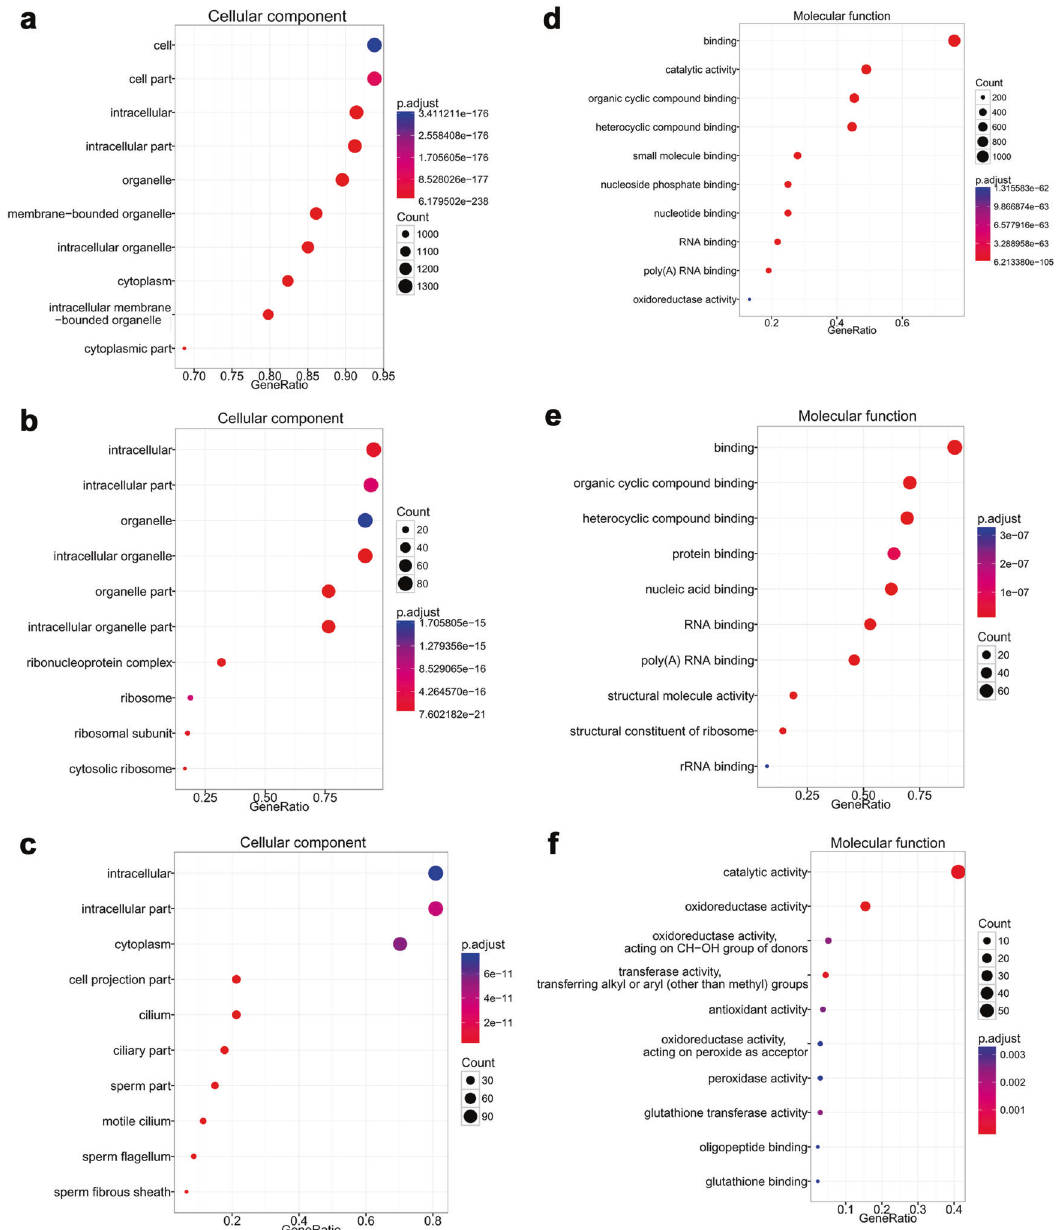
Fig. 6 Cellular components and molecular functions of GO analysis. a – c Cellular components of total identi fi ed proteins, proteins upregulated, and proteins downregulated upon H 2 O 2 treatment. d – f Molecular functions of total identi fi ed proteins, proteins upregulated, and proteins downregulated upon H 2 O 2